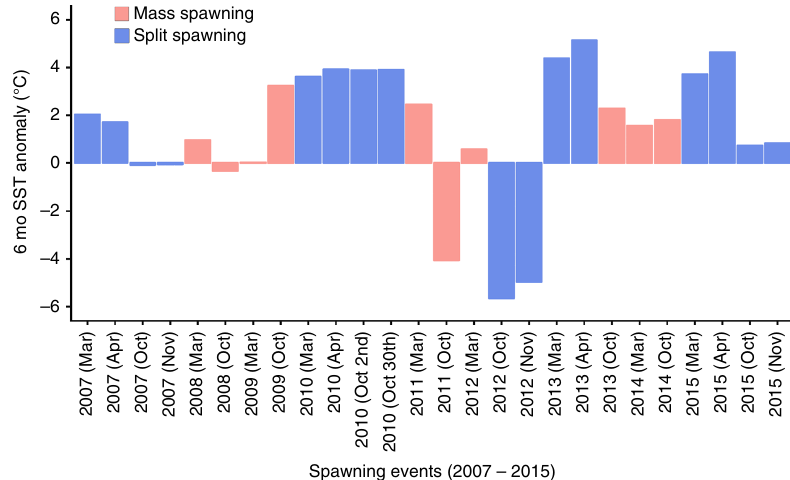
Fig. 3 Cumulative sea surface temperature anomalies for the 6-months prior to each coral spawning event at Scott Reef from 2007 until 2015. Mass spawning events are shown with pink bars and split spawning events are shown with